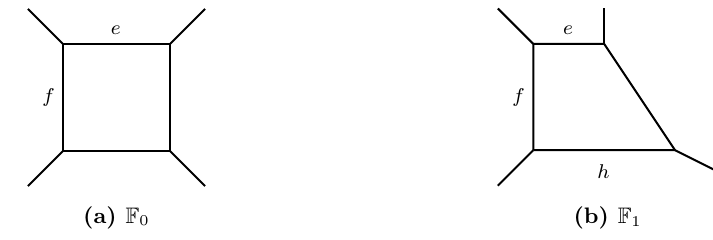
Figure 1. Geometric constructions of (a) SU(2) 0 and (b) SU(2) π . The fiber P 1 in a Hirzebruch surface F n is denoted by f , the base P 1 is denoted by e , and h = e + f for F 1 . coming from a wrapped M2-brane on the fiber curve f . This state is a W-boson with gauge charge +2 and it feels an integer magnetic flux 2 n , which is compatible with the quantization condition in